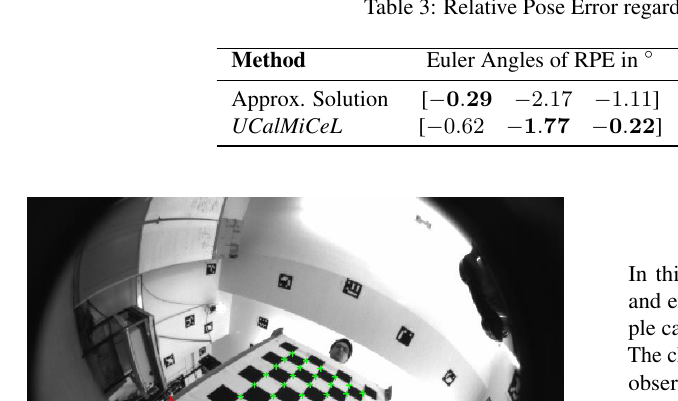
Table 3: Relative Pose Error regarding to ground truth